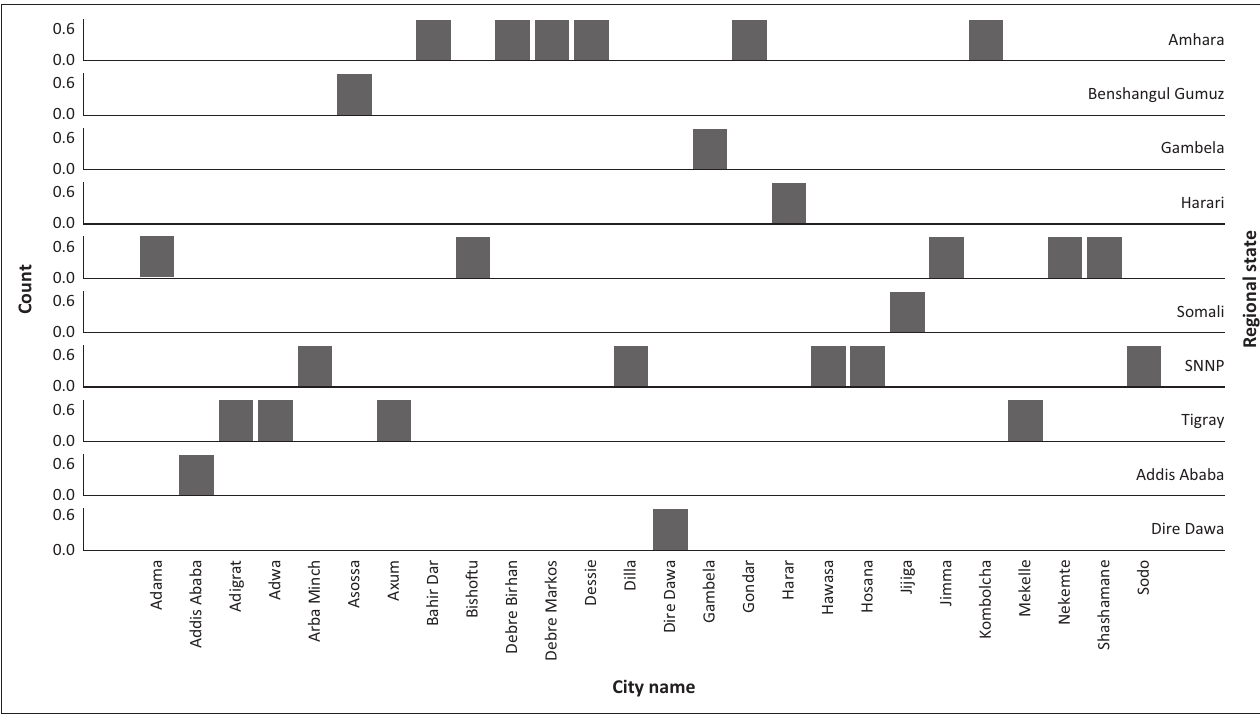
FIGURE 3: Number of sampled cities per